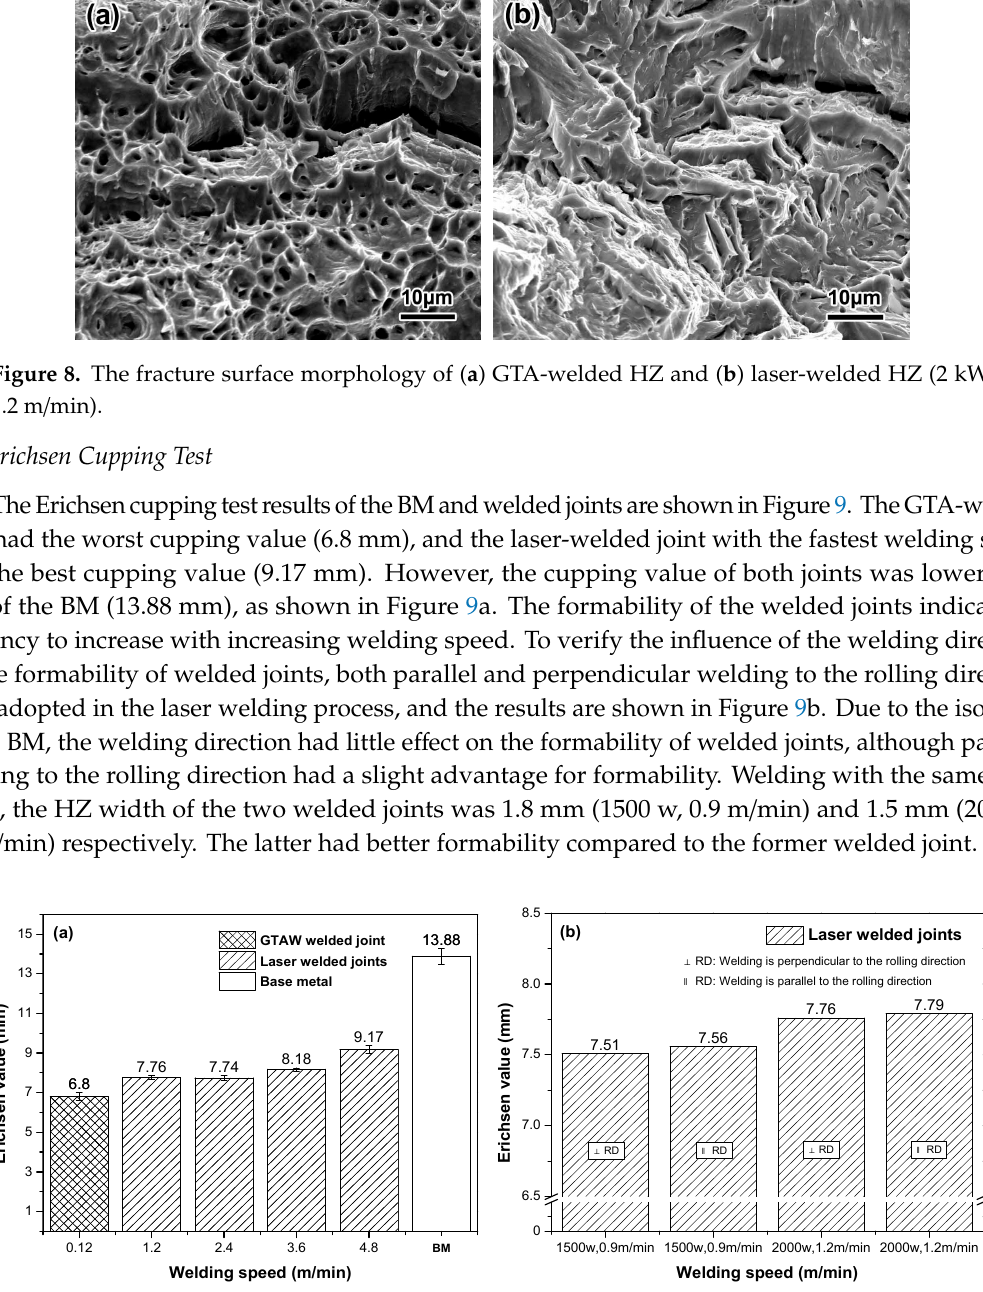
Figure 7. The mechanical properties of ( a ) ultimate tensile strength (UTS) and yield strength (YS); ( b ) elongation of the welded joints and HZ.